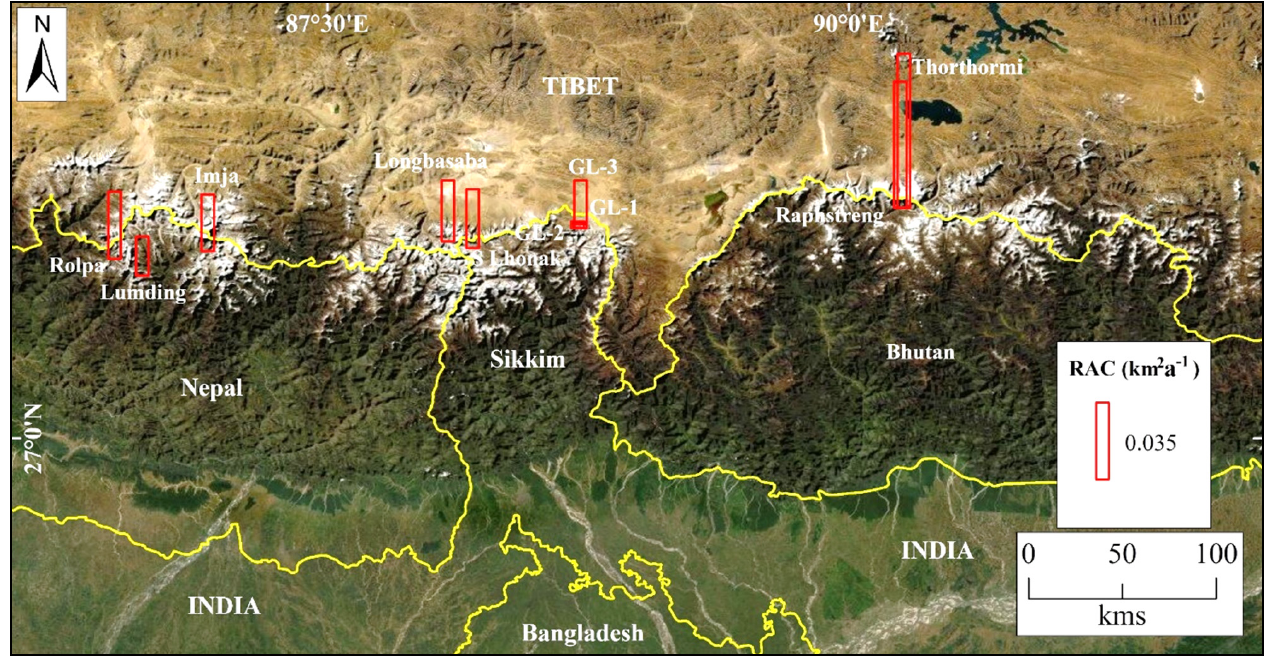
Figure 8. Rate of area change (RAC; km 2 a − 1 ) of some potentially dangerous glacial lakes in the Eastern Himalayas. Data sources: Thorthormi [73,74]; Raphstreng [73]; GL − 1, GL − 2, GL − 3 (this study); South Lhonak [25]; Longbasaba [75]; Imja [76,77]; Lumding [14]; Tso Rolpa [7]. The base map is the hillshade World Imagery (ESRI).